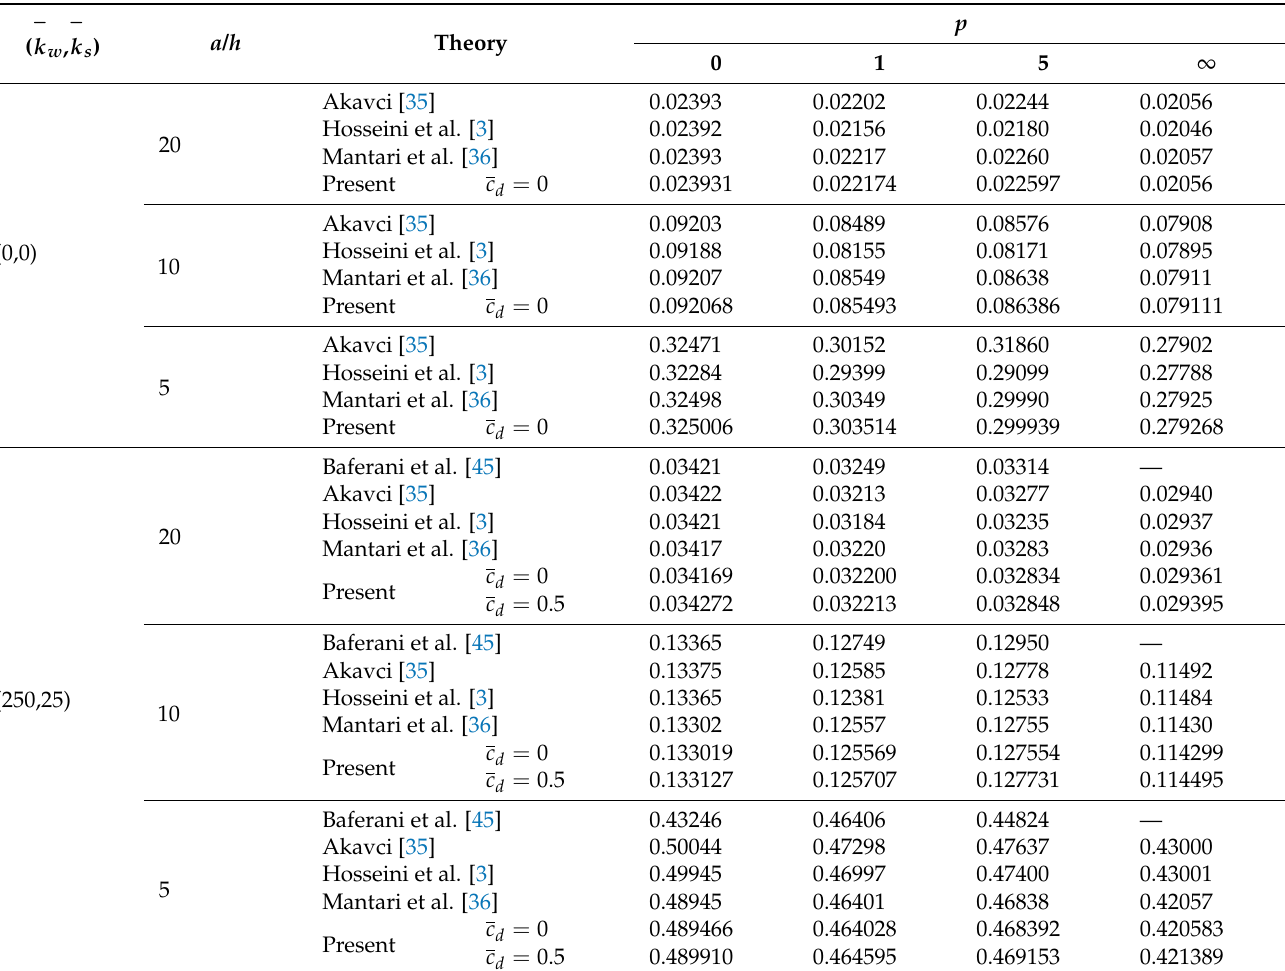
Table 16. Non-dimensional fundamental frequencies (cid:101) ω = ω h plates ( a / b =